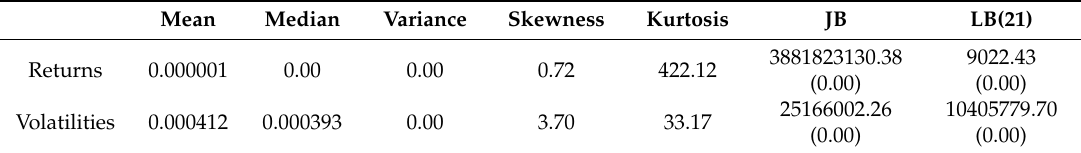
Table 2. Summary statistic of five-minute USD / AUD returns and volatilities.